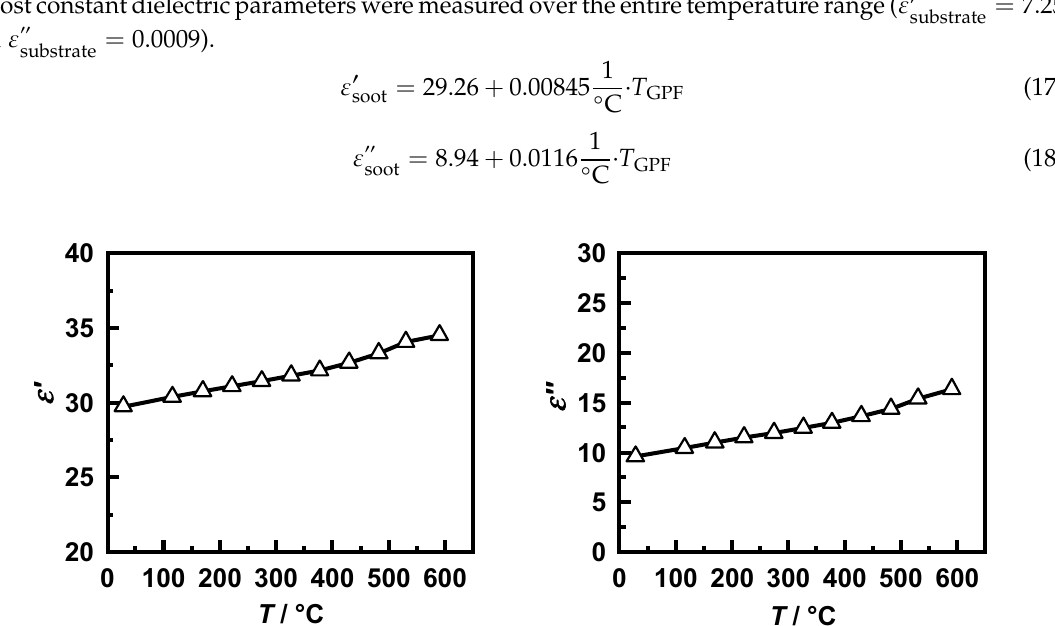
(cid:48) = 7.25 substrate